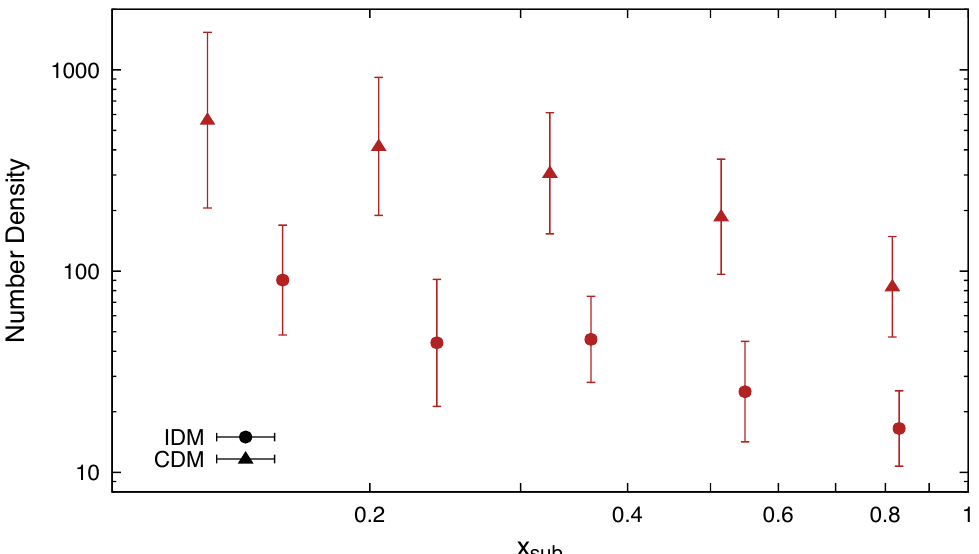
Figure 6. Number density of subhalos as a function of distance to the host halo centre, x sub = r sub / R 200 . We show results for both IDM (circle symbols) and CDM (triangles). Both cases refer to the LG simulation set; see the text for